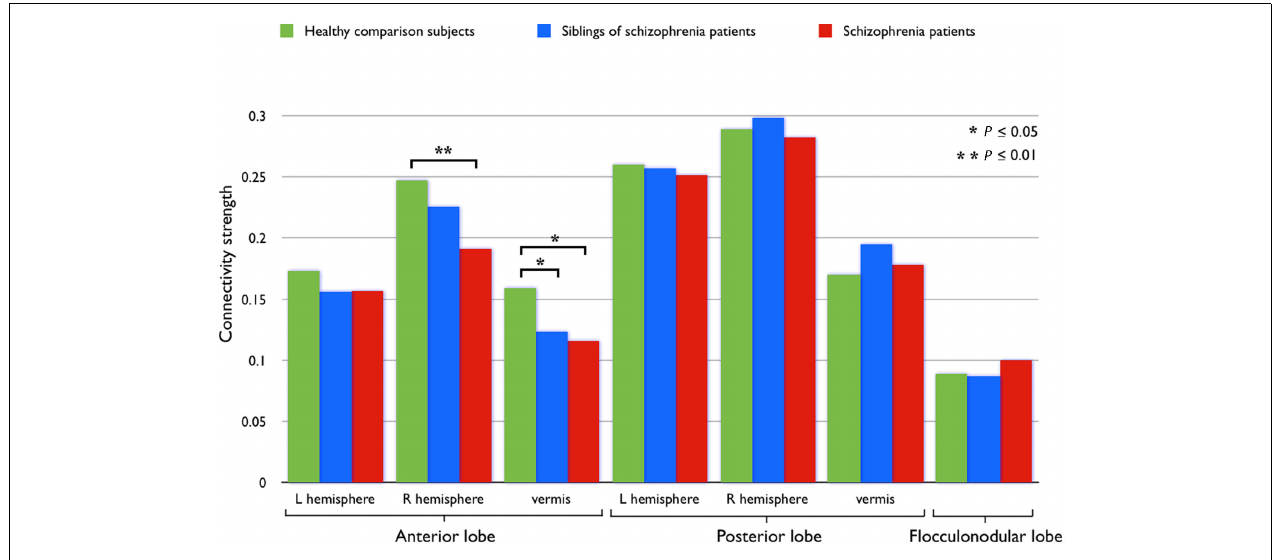
FIGURE 4 | Connectivity strength per cerebellar ROI. Connectivity strength S, as the average of all correlations (unthresholded) between the cerebellar ROI and all extra-cerebellar regions in the brain, per subject group.